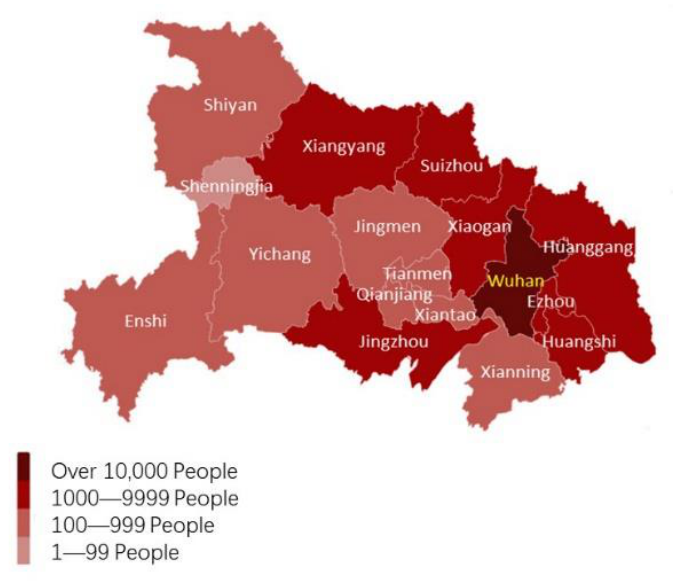
Figure 7. Pandemic situation in Hubei